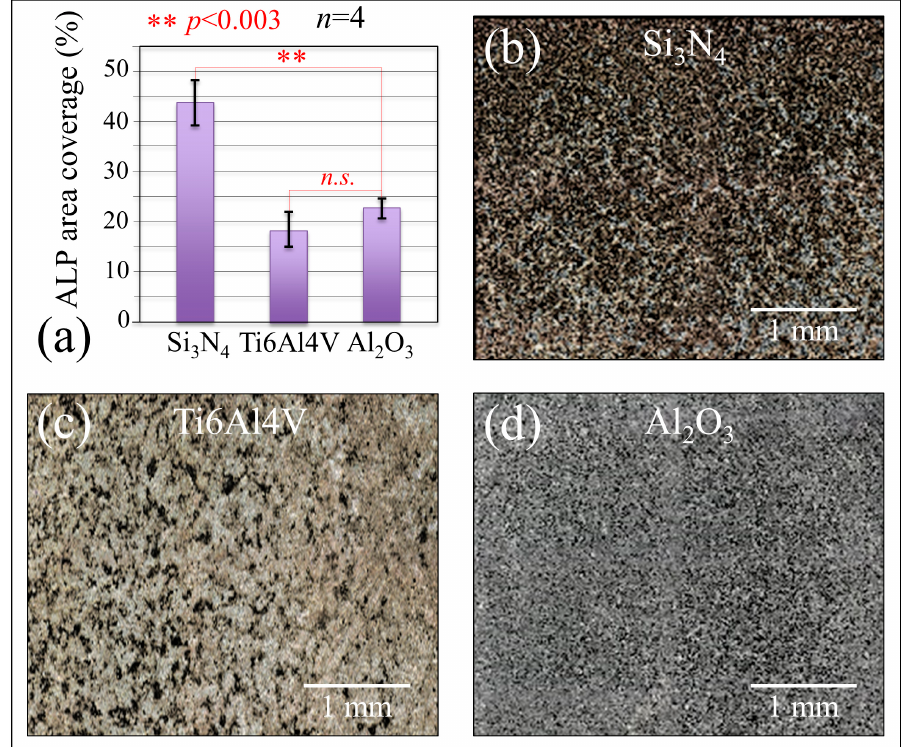
Figure 4. In ( a ), quantitative assessment of ALP concentration as obtained from stained micrographs on Si 3 N 4 ( b ), Ti6Al4V ( c ), and Al 2 O 3 ( d ).